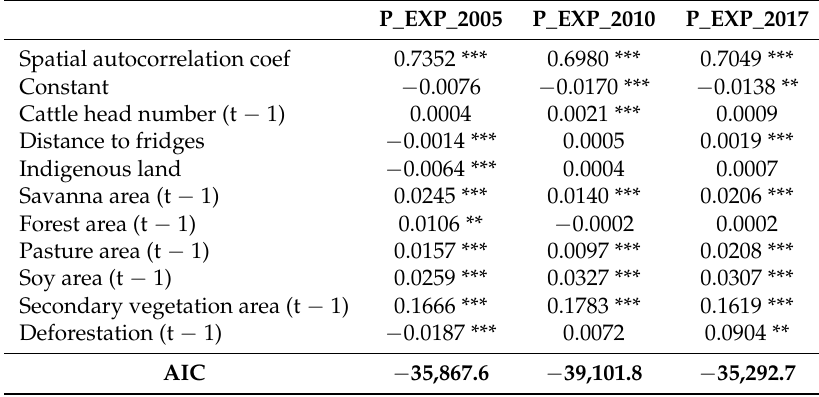
Table 3. Spatial lag regression models for pasture expansion determinant factors.